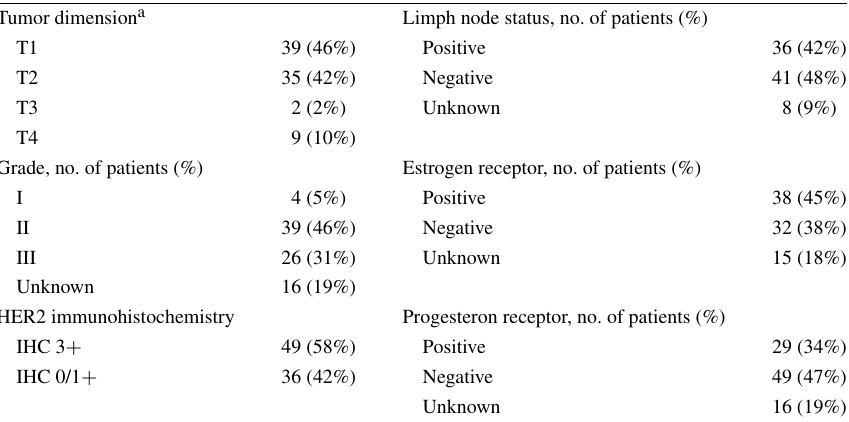
Clinical characteristics of the cancer